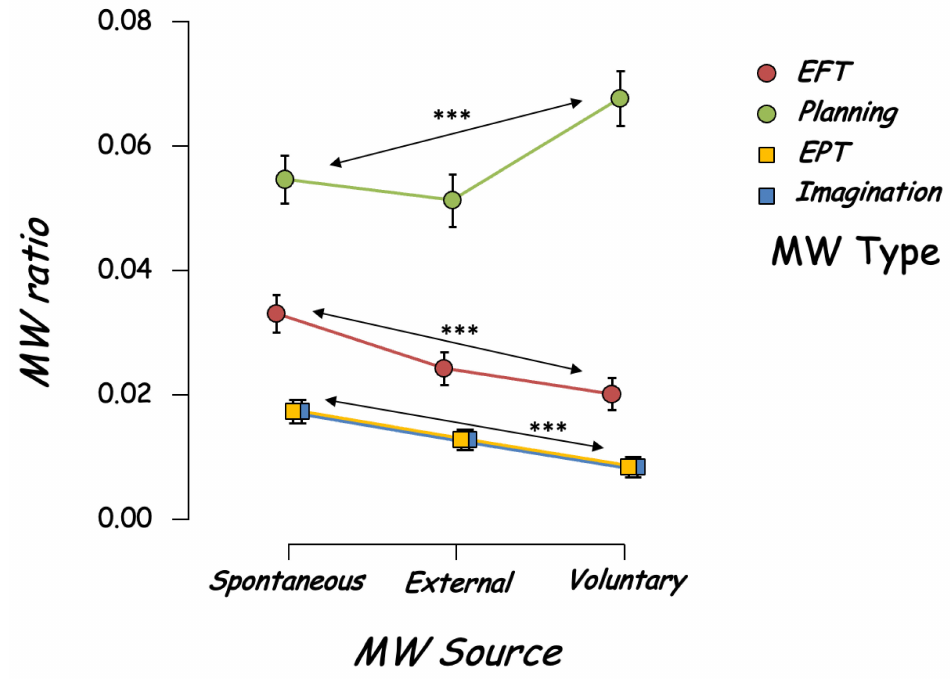
Figure 5. Interaction between MW contents and source frequency. *** p <